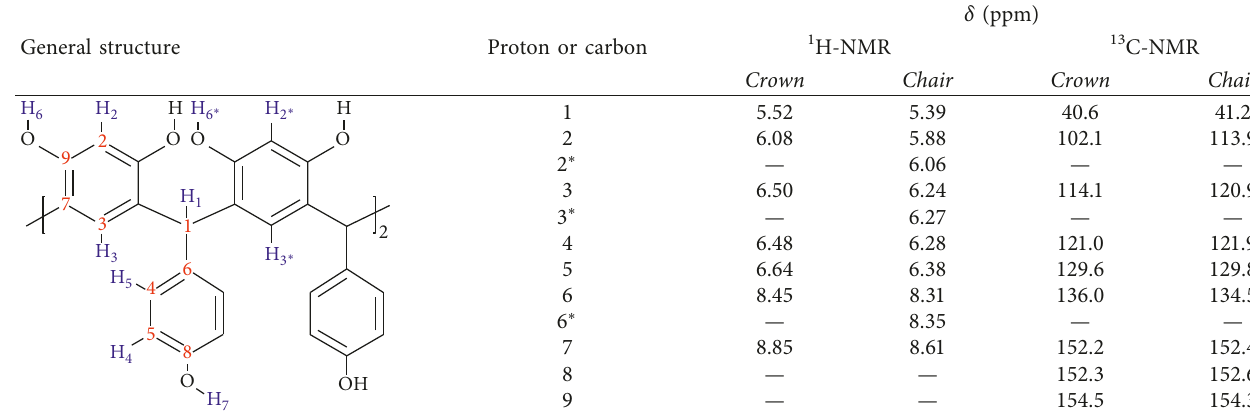
Table 1: Chemical shifts for pure stereoisomers crown and chair in 1 H-NMR and 13 C-NMR spectra. General